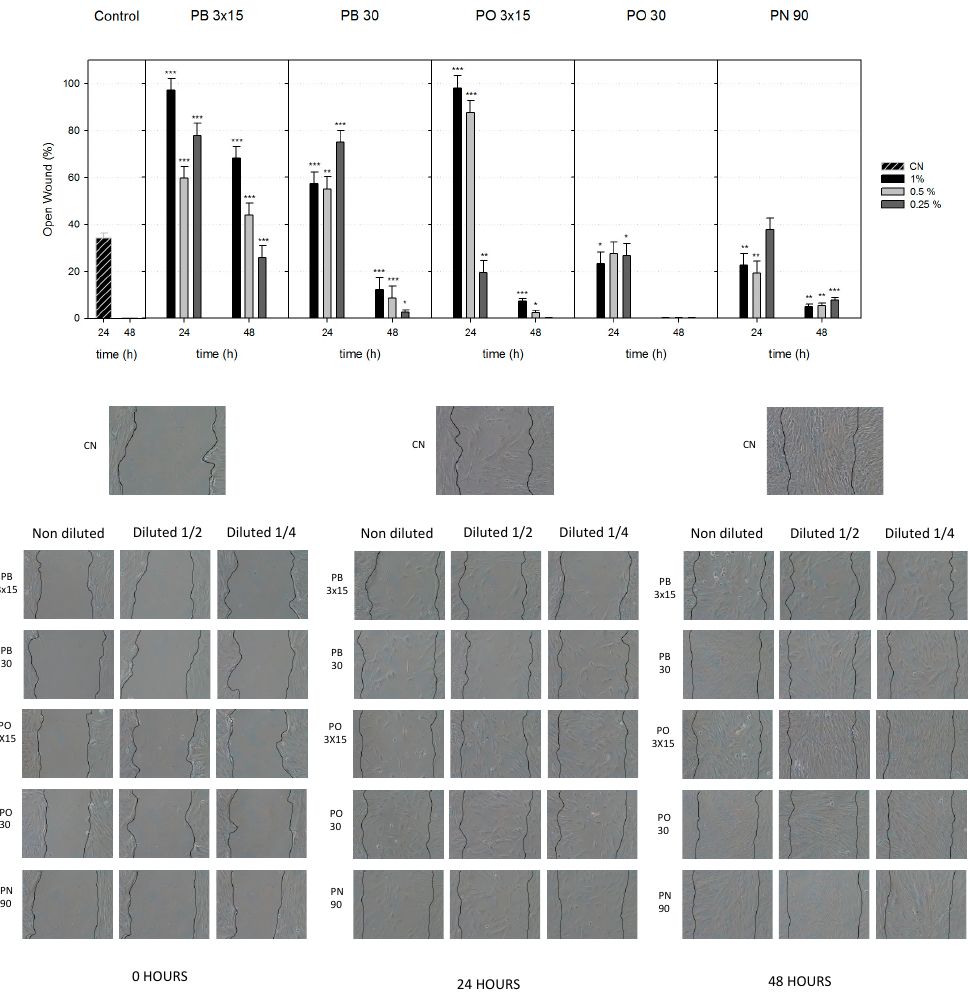
Figure 4. Wound-healing assay. Observation of wound closure change. Confluent hDPSCs were wounded and stimulated with bleaching extracts for up to 48 h. Cell migration is represented as the percentage of the open wound area under each condition compared with the control (* p < 0.05; ** p < 0.01; *** p < 0.001), which was analysed using one-way ANOVA.